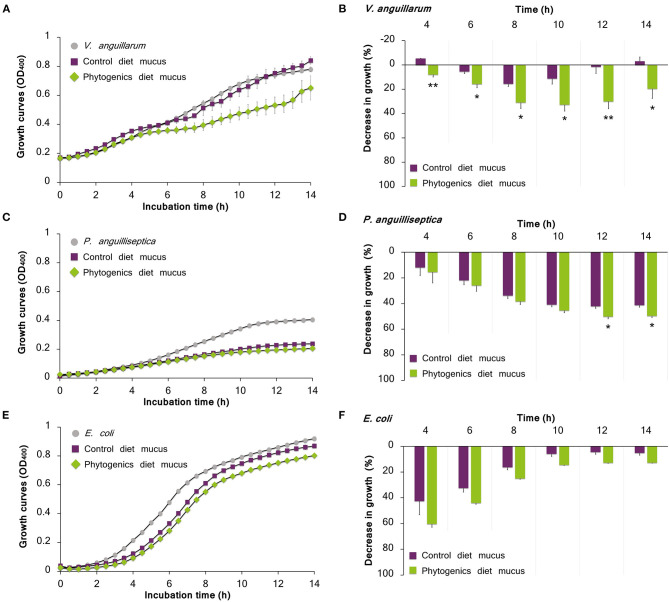
Bacterial growth on skin mucus of juvenile gilthead seabream (Sparus aurata) fed a diet supplemented with a blend of garlic essential oil, carvacrol and thymol, and a control diet devoid of the feed additive. Mucus samples were obtained from 3 pools of 6 individual fish. Data correspond to the mean ± SEM of triplicate bacterial growth curves of V. anguillarum
(A), P. anguilliseptica
(C) and E. coli
(E). Gray circles correspond to bacteria growth in medium devoid of mucus; purple squares correspond to bacteria growth in the mucus of fish fed the control diet; and green rhombus correspond to bacteria growth in the mucus of fish fed the phytogenic-supplemented diet. Details on the statistical differences in bacterial growth between the experimental dietary groups is provided by the percentage of decrease in growth of V. anguillarum
(B), P. anguilliseptica
(D), and E. coli
(F). Asterisks indicate significant differences in bacterial growth between dietary groups (t-test, P < 0.05).